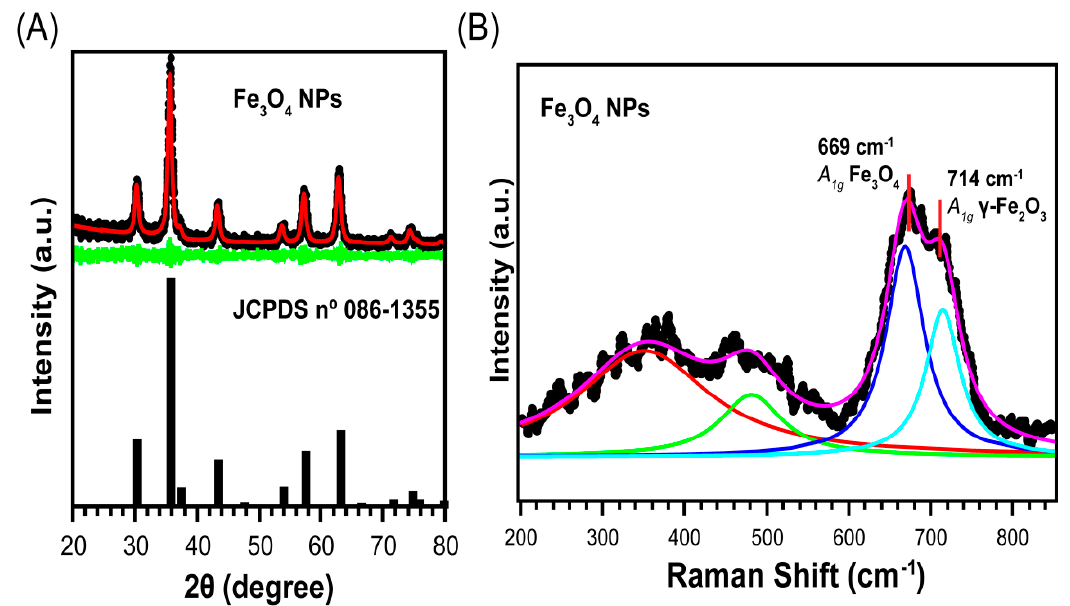
Figure 1. ( A ) XRD patterns of the Fe 3 O 4 NPs synthesized herein; black dots and the red and green lines represent the measurement data, adjusted di ff ractogram and subtraction between the measurement data and adjusted di ff ractogram, respectively. ( B ) Raman spectrum of the Fe 3 O 4 NPs; black dots and the pink line are the measurement data and the Lorentzian fit, respectively. Other colored lines are adjusted vibrational modes of the Fe 3 O 4 NPs. Further details are given in Section 3.